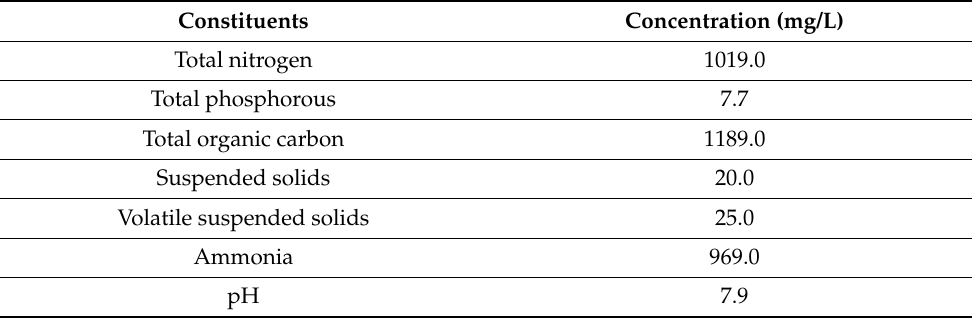
Table 1. Characteristics of Ämmässuo leachate from Point